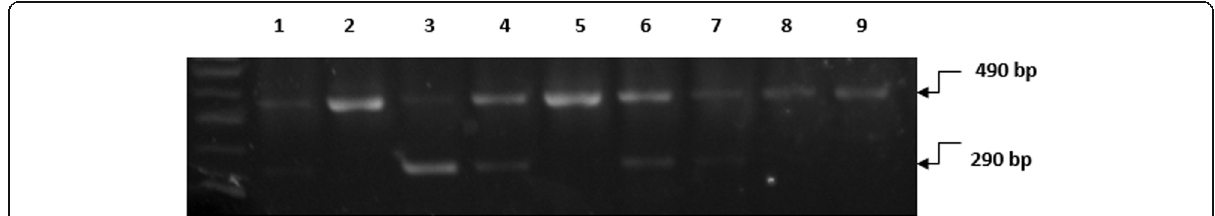
Table 1 Frequency distribution of TaqI and ApaI genotypes among non-osteoporotic and osteoporotic groups Variables Non-osteoporotic ( N = 74) Osteoporotic ( N = 23) Chi-square N % N % Vit. D receptor Taq1 Homo